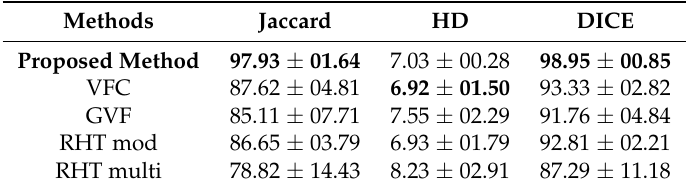
Table 4. Overlap and Distance metrics for different compared methods. Comparison between proposed method and literature works.